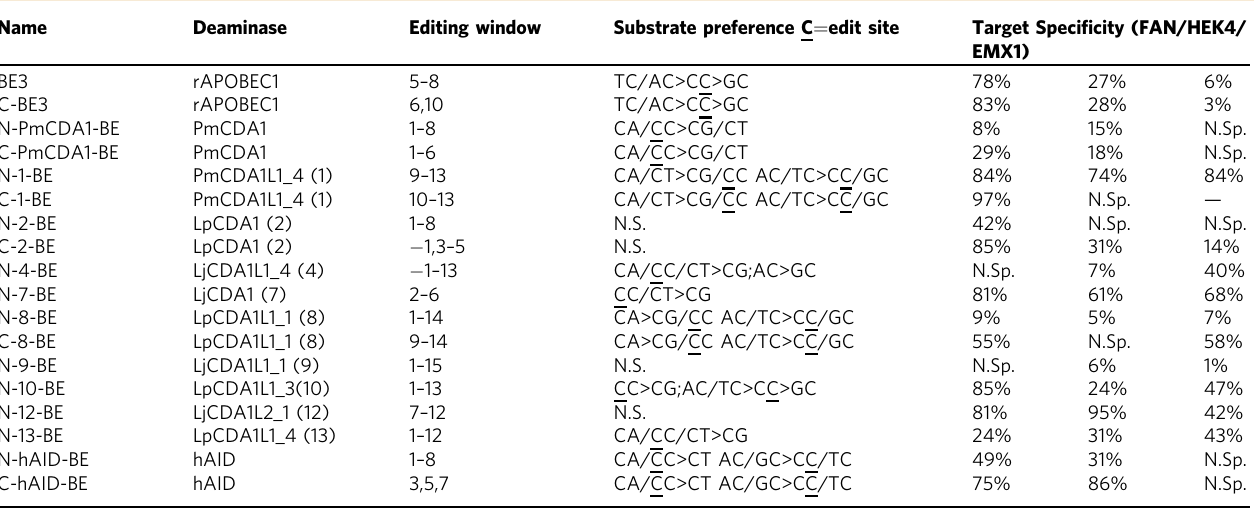
Table 1 Features of different C – T base editors in this